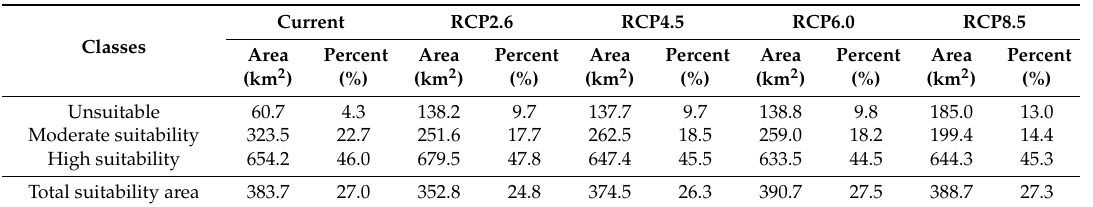
Table 5. The statistic area of Qinghai spruce’ actual distribution in four classes under current and four